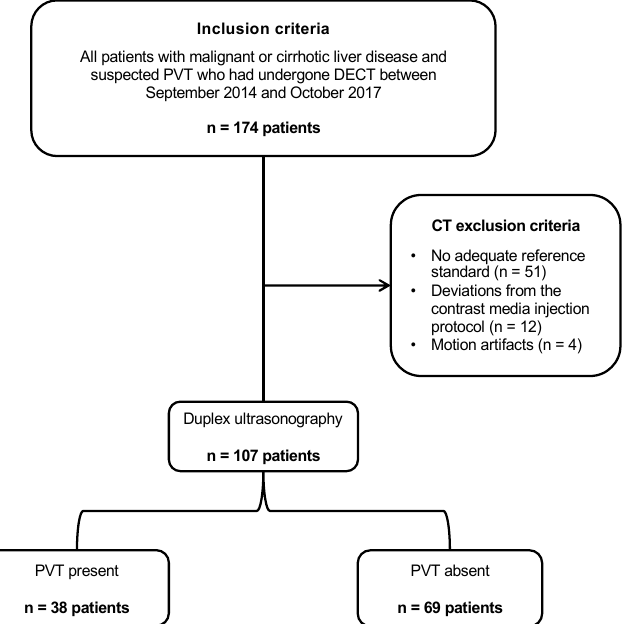
Figure 1. The analytic population included 107 patients with malignant or cirrhotic liver disease and suspected portal vein thrombosis (PVT) who had undergone dual-energy CT (DECT) examinations of the abdomen. PVT = portal vein thrombosis. Table 1. Patient characteristics.